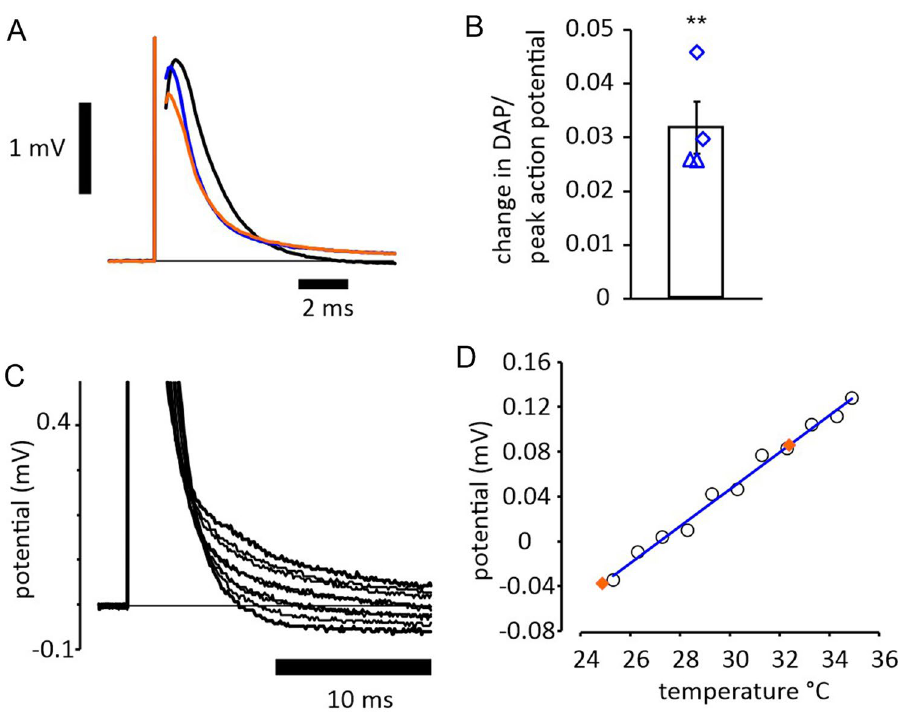
Figure 1. IR-laser light affects supramaximal evoked action potentials in a manner similar to whole-bath warming. ( A ) Control action potential evoked at a bath temperature of 25 °C (black trace), and at 32 °C (blue trace). With an ambient bath temperature of 25 °C, application of continuous laser light at the site of recording gives the third action potential (orange) within seconds, an effect sustained during the light application. The action potentials recorded either in the warmer bath, or with laser light application appear briefer, and have longer depolarizing afterpotentials (DAP). ( B ) A similar effect was observed in 4 nerves, with an increase in the DAP at 10 ms following stimulation near 3% of the peak action potential amplitude ( P = 0.007, single-sample t-test, compared with 0), and not obviously affected by the presence of bumetanide and amiloride (5 µM and 10 µM, respectively), in the recording solution (control solution: blue diamonds; with Na + transport blockers: blue triangles). For one nerve in control solution the change in the afterpotentials is shown in more detail in ( C ), with a gradually increasing ambient temperature from 25 to 35 °C and a monotonically increasing afterpotential. The relationship between DAP amplitude and ambient temperature, measured at 10 ms, is shown in ( D ), and superimposed are the measurements of DAP amplitude without and with laser light at an ambient temperature of 25 °C (orange diamonds). Simple comparison suggests the laser light produces a local warming of 7 °C in this nerve, although a part of the effect may be caused by changes in myelin function. As already reported, the changes in appearance of the action potential with warming are largely caused by changes in action potential kinetics, rather than conduction